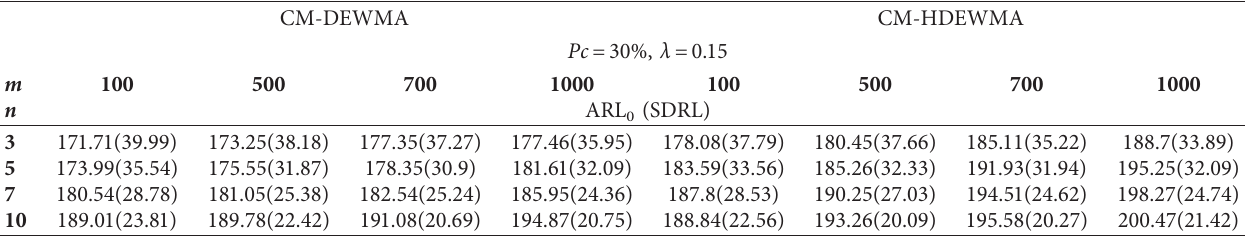
Table 13: Estimation effect on ARL 0 at different values of m and n for CM-DEWMA and CM-HDEWMA control charts assuming � α ⌢ � 0 . 5 , β � 0 . 5 , λ � 0.15, and ARL 0